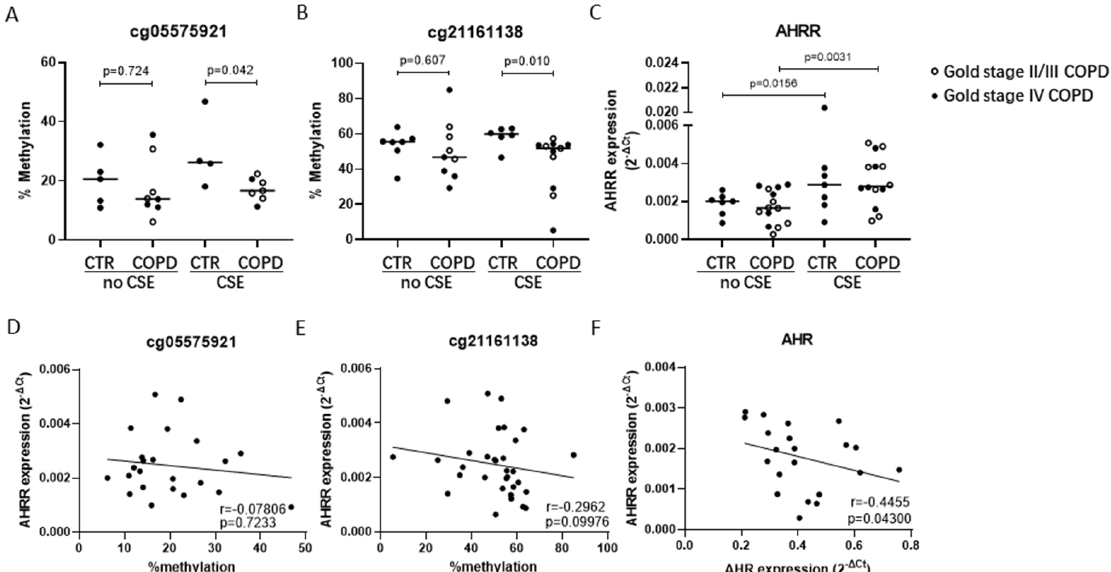
Figure 2. DNA methylation levels and mRNA expression of AHRR and the correlation of AHRR mRNA levels with AHRR DNA methylation or AHR expression in airway epithelial cells (AECs). AECs from 8 ex-smoking non-COPD controls (CTR) and 14 COPD (GOLD stage II-IV) patients were cultured until confluence, hormonally deprived overnight and incubated in medium with/without 7.5% CSE for 24 h. DNA and RNA were isolated for assessment of DNA methylation and mRNA expression levels. DNA methylation was assessed at CpG-sites cg05575921 ( A ) and cg21161138 ( B ) of AHRR by pyrosequencing. Samples that did not pass the pyrosequencing quality control were excluded. AHRR mRNA expression was assessed by qPCR ( C ), related to the expression of housekeeping genes B2M and PPIA and expressed as 2 − ∆ Ct . Correlation between AHRR mRNA expression and DNA methylation levels of cg05575921 ( D ) or cg21161138 ( E ) in AECs exposed to 7.5% CSE or medium control (no CSE) from non-COPD controls and COPD patients. The correlation of mRNA expression between AHRR and AHR ( F ) in non-exposed AECs from non-COPD controls and COPD patients. Differences between CTR and COPD were tested using the Mann–Whitney test, differences between no CSE and CSE were tested using the Wilcoxon rank-sum test and correlations were tested using Spearman correlation test. p -values and median levels are indicated. In COPD groups, the empty symbols indicate GOLD stage II and III patients, and the filled symbols indicate GOLD stage IV COPD